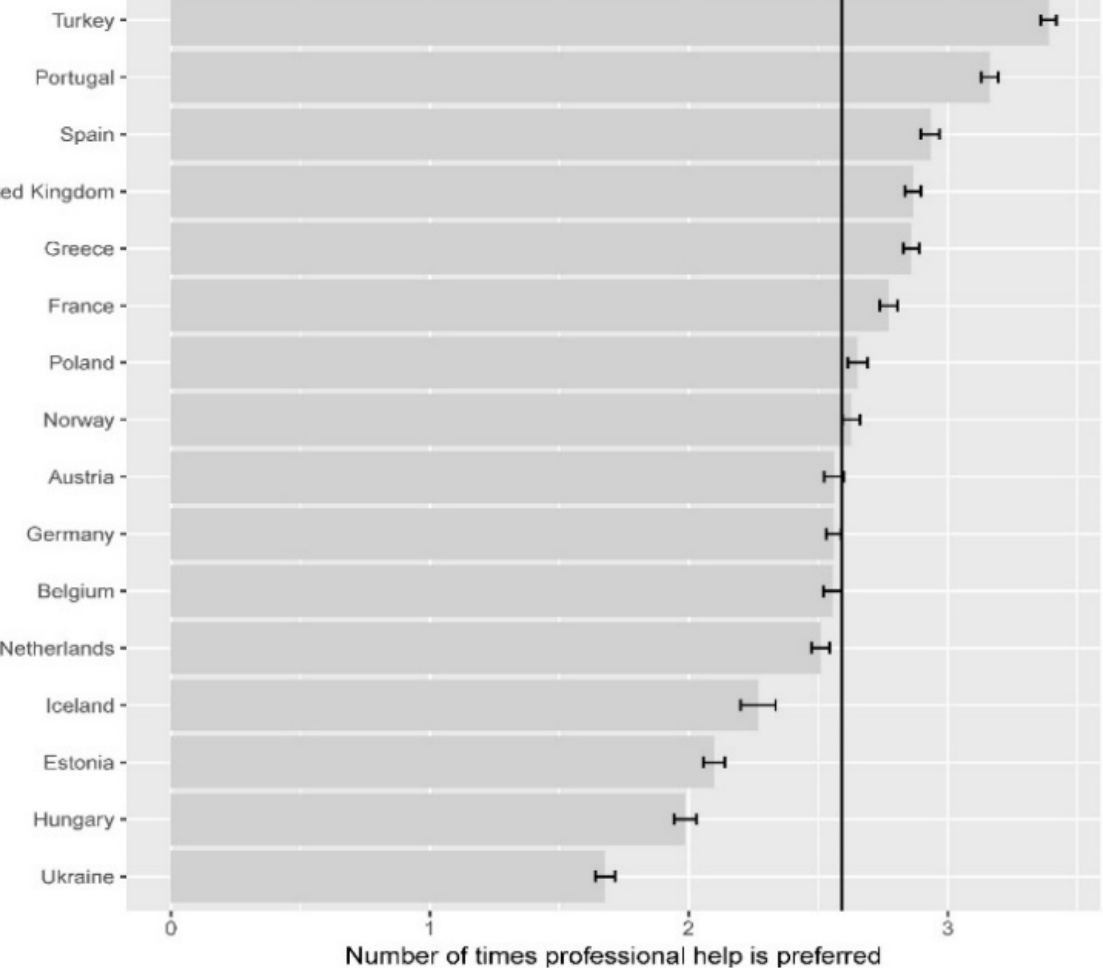
Figure 2. Preference for professional medical help in non-acute medical situations is a summated scale, showing preference or either professional help (1) or help from other sources (0) in the situation of serious headache, stomach-ache, back-ache or sleeping problems. Preference in these situations is summated into individual scores from 0 (preference for professional help in no situation) to 4 (always prefer professional help). The vertical line indicates the overall mean. For each nation the 5% confidence limits are shown; the graph indicates that there are substantial differences between nations in preference for professional medical help, with respondents from Turkey being the most prone to choose for professional help and respondents from Ukraine the